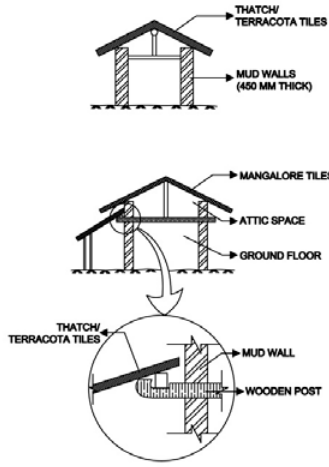
fig. 2. Typical types of mud huts in studied area Source: sketched by